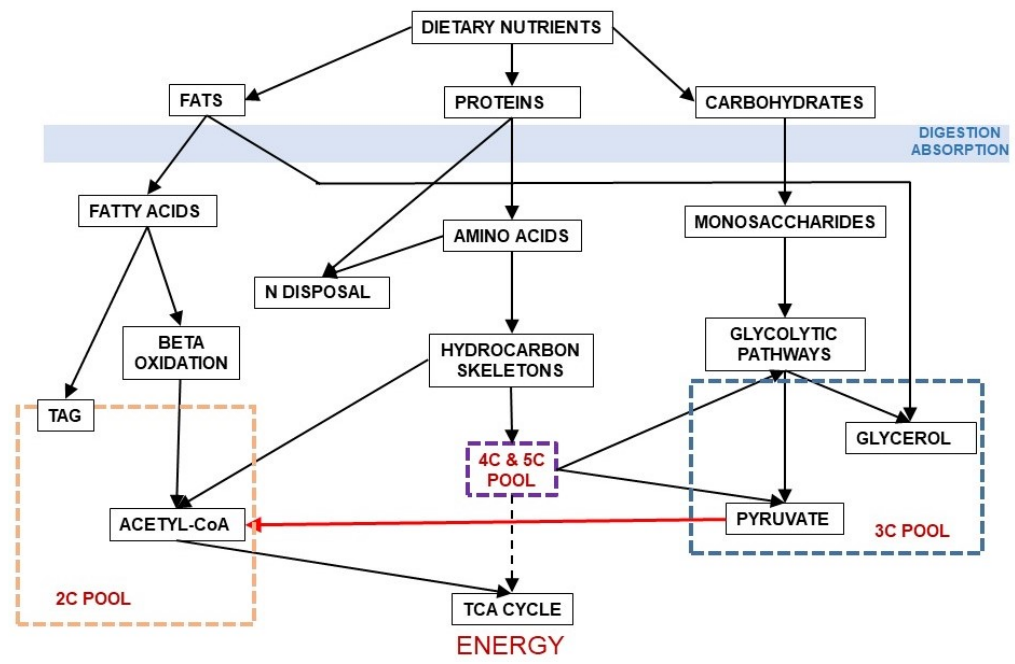
Figure 3. Relationship between the main groups of dietary nutrients driving to the formation of 2C and 3C fragments. In red, the irreversible decarboxylative oxidation path of pyruvate (3C) to acetyl- CoA (2C).